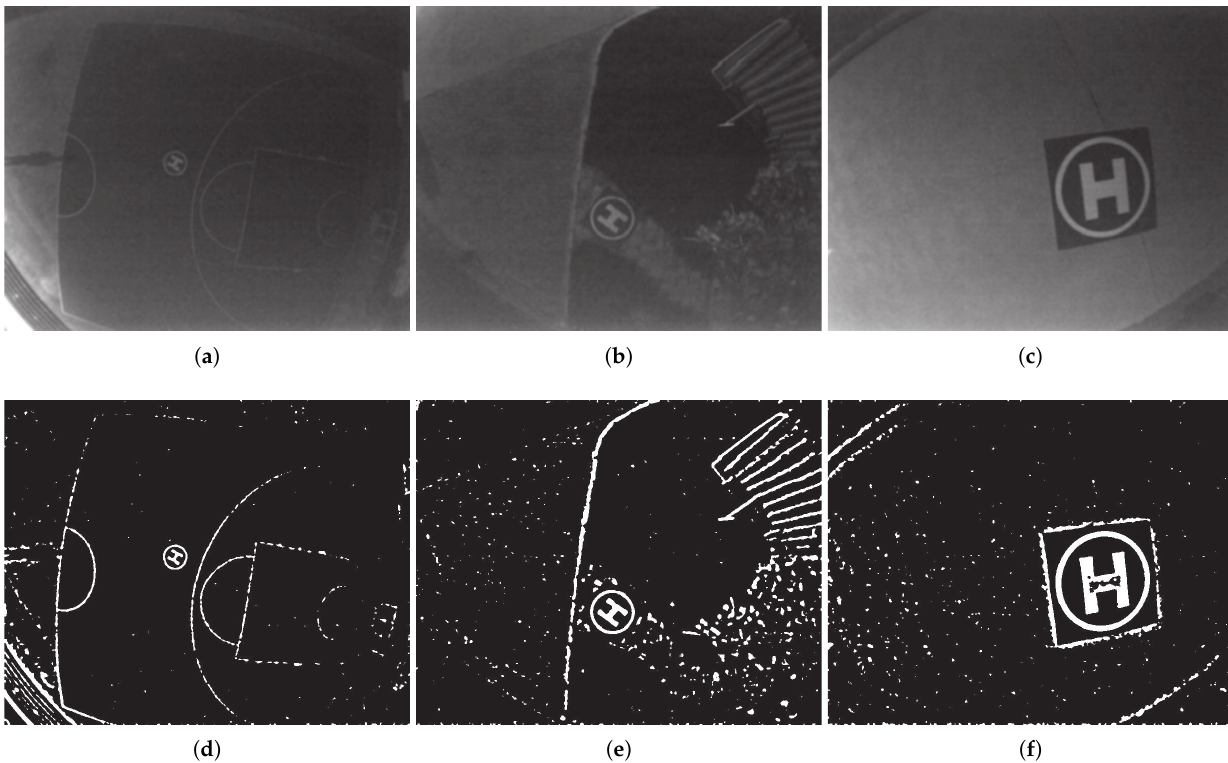
Figure 4. Adaptive thresholding results at different scenes and altitudes: ( a – c ) The enhanced and filtered field experiment images captured at the “Approaching” phase (GNSS altitude 8.32 m), the “Hovering” phase (GNSS altitude 6.58 m), and the “Descending” phase (GNSS altitude 2.91 m), respectively. ( d – f ) The corresponding images after adaptive thresholding using box sizes 29, 41, and 51,